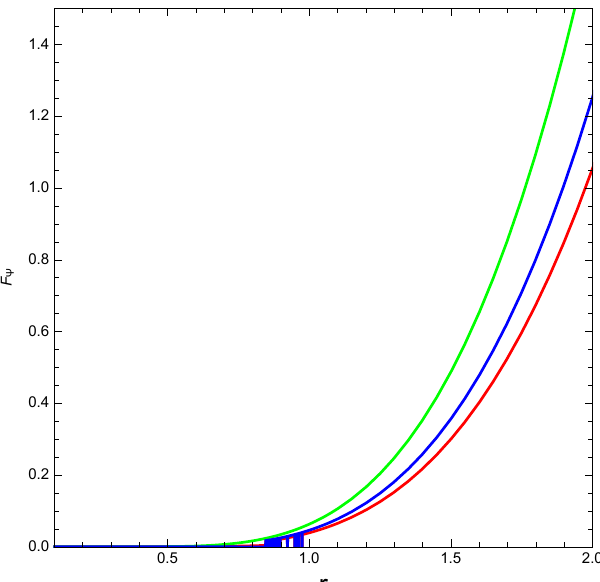
Figure 12. Solution of F ( R ( r )) for R adopted as an exponential function of radius. The evolution of partial derivative of f ( R ) is obtained by comparing Equation (8) and Equation (33). We have fixed the values of a 0 , a 1 , a 2 , K , and C 1 . The red, green, and blue lines correspond to small perturbations of λ 0 , Ψ 0 , η 1 , η 2 , and η 3 , respectively.